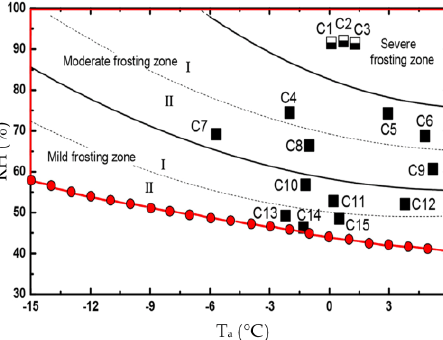
Figure 9. Test conditions shown on the frosting zone in frosting map for case 1–15 [63].